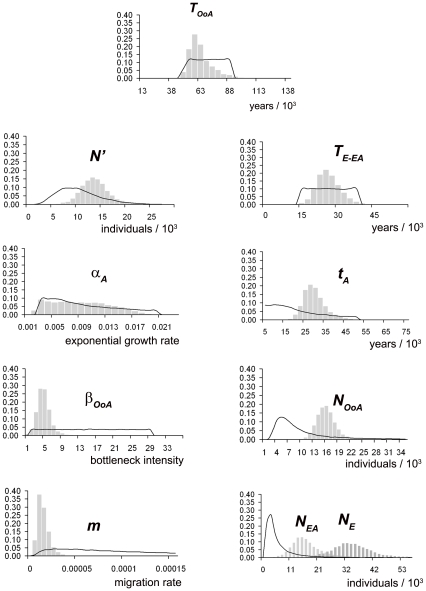
Approximate posterior distributions of historical and demographic parameters.This figure gives the estimated ABC posterior distributions of the historical and demographic parameters (Table 3) using the RAOEB model (Figure 4A) with best-fitted priors (Table 2). Black lines represent the prior distributions and grey bars the posterior distributions. The times were translated into years using a generation time equal to 25 years. The posterior distributions of the parameters where the estimations were not validated by means of the accuracy evaluation procedure are not presented (i.e. NA and δ).